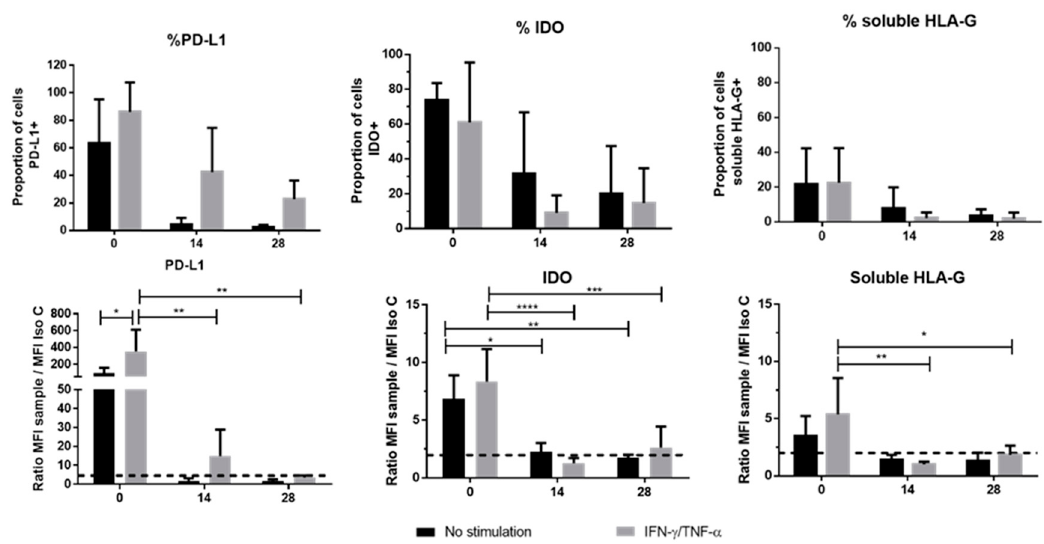
Figure 5. Immune checkpoint molecules involved in cell immunomodulation. Membrane Programmed death-ligand 1 (PD-L1), Indoleamine 2,3 dioxygenase (IDO) enzyme and soluble Human Leucocyte Antigen G (HLA-G) were studied on Day 0 (monolayer) and during chondrogenic di ff erentiation (Day 14 and 28) in two conditions (with stimulation (grey color) or without stimulation (black color). Results were obtained by flow cytometry and calculated calculated in proportion of positive cell for each marker (up results) and in ratio of mean fluorescence intensity of the sample compared with the isotypic control (down results). The dotted lines represent the expression level for each molecule (ratio higher than 2 between sample and isotypic control). Data are expressed as mean ± SD ( N = 3 independent cords minimum), * p < 0.05; ** p < 0.01; *** p < 0,001; **** p <